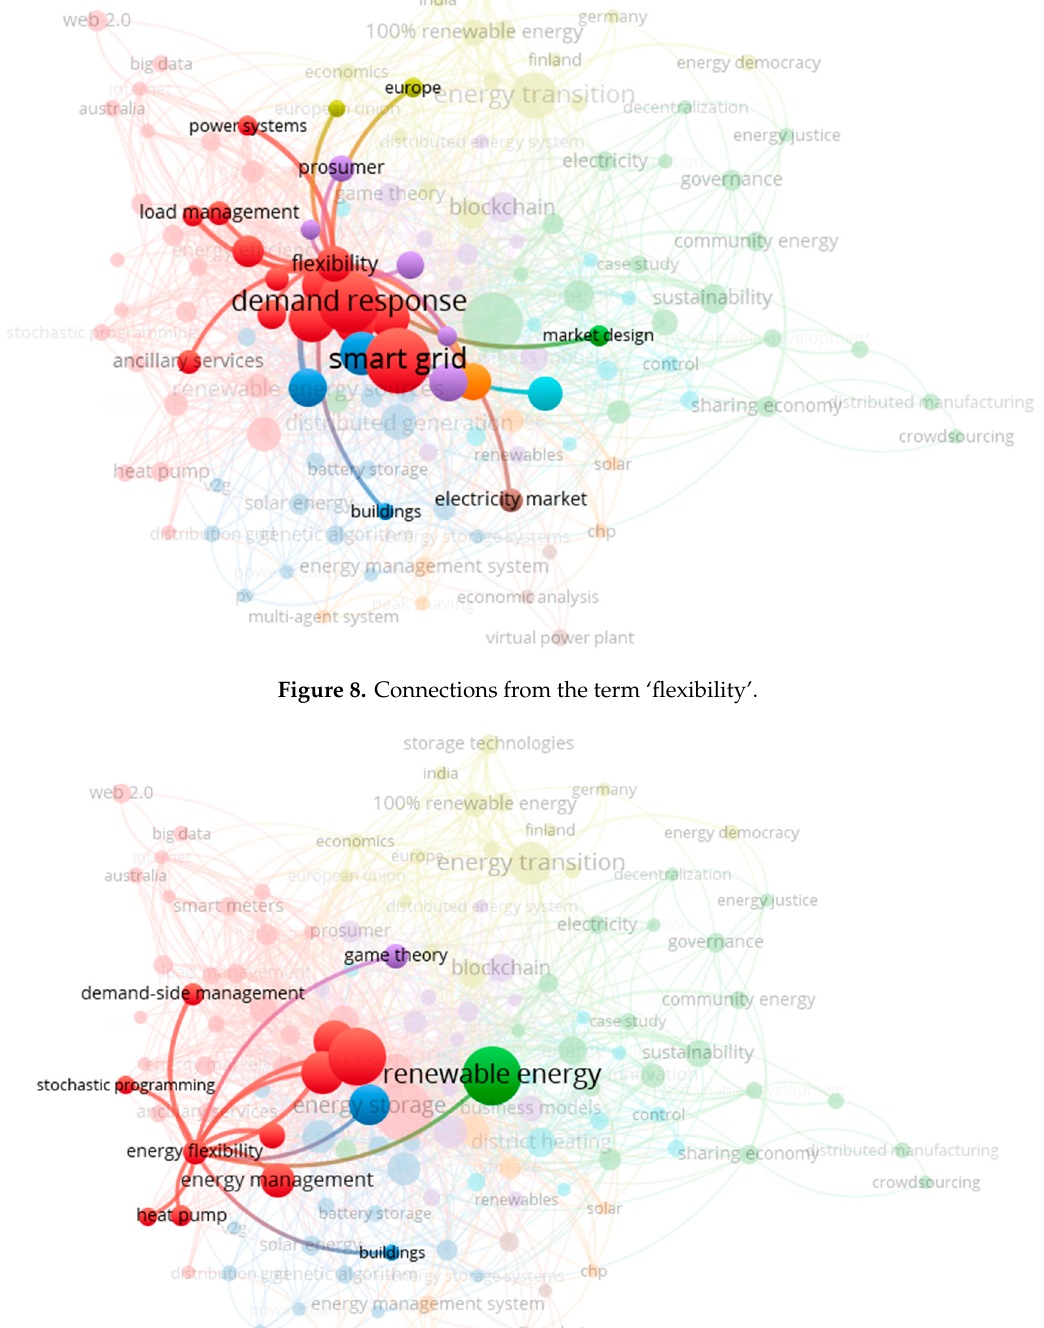
Figure 9. Connections from the term ‘energy flexibility’.